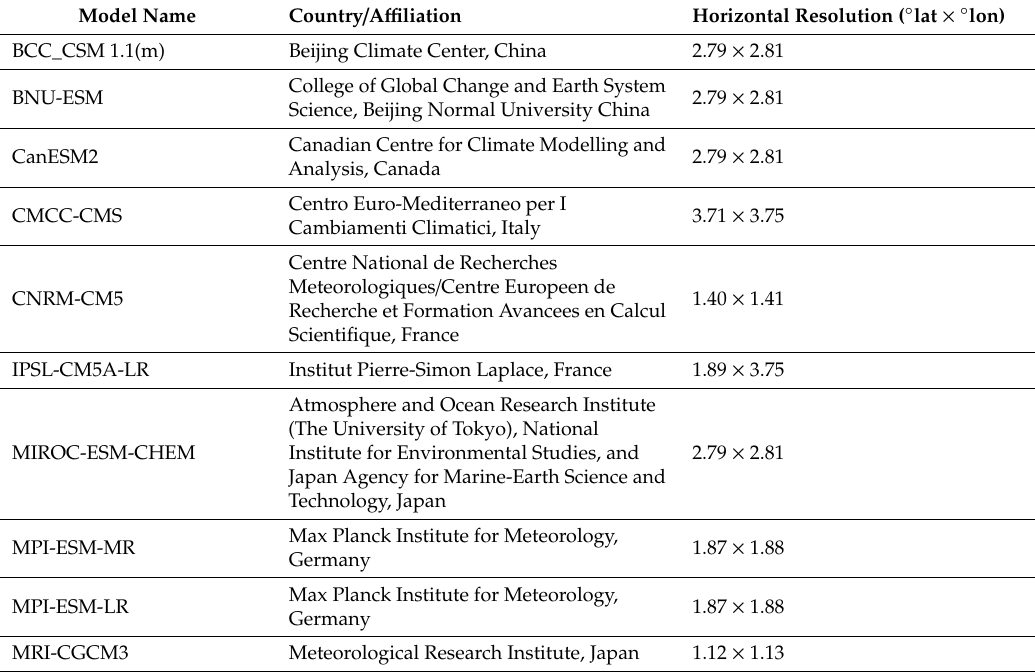
Table 1. Details and characteristics of CMIP5 models